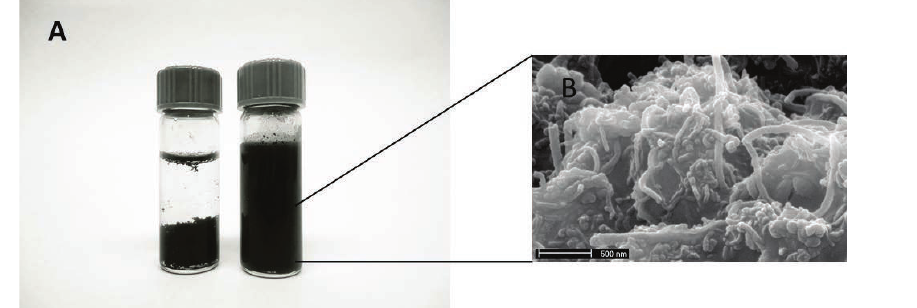
Figure 3. (A) Photographs of flasks containing 1.0 mg mL -1 MWCNTs dispersed in water (left) and in 1.0 mg mL -1 DHP solution by ultrasonication (right). Image A was taken 2 h after MWCNTs were dispersed in water or DHP, (B) SEM images of MWCNTs–DHP on the surface of GC Fig. 3A, which compares the MWCNTs dispersed in water (left) and in 1.0 mg mL -1 DHP (right). Also depicted Fig. 3B shows the SEM images of MWCNTs-DHP on the